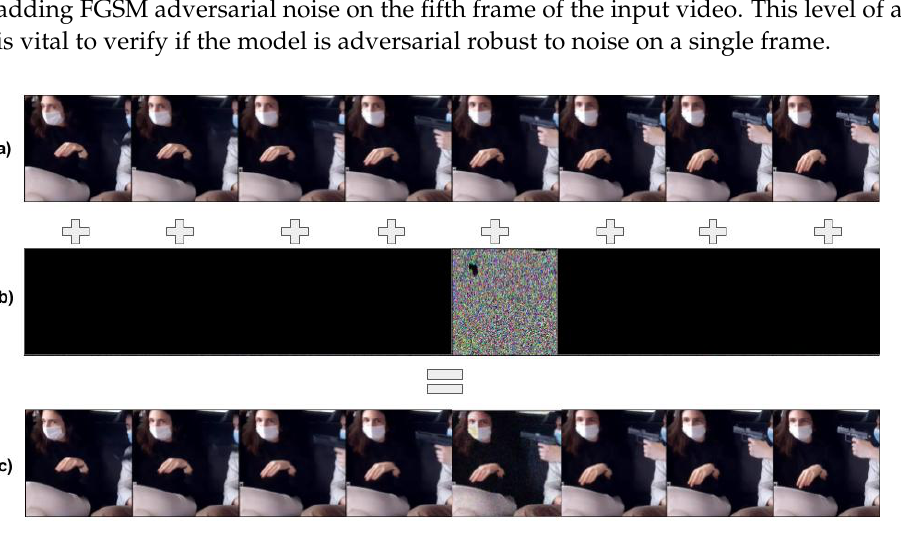
Figure 4. Frame-level adversarial attack. This example shows how we can compute the frame-level adversarial attack. The ( a ) represents the input video, ( b ) the frame adversarial noise, and ( c ) the frame-level adversarial attack. In this example, we only add adversarial noise on the fifth